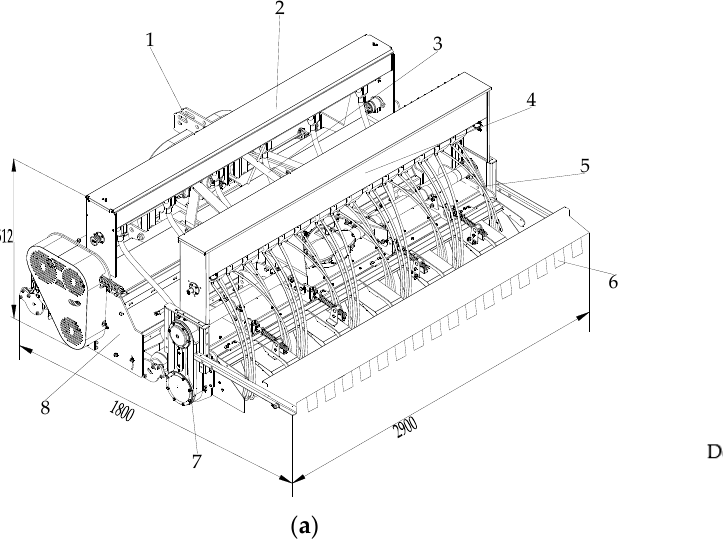
Figure 2. Overall structure of the wheat wide-seed-belt sowing and covering soil test bed: (1) hanging at the first three points; (2) fertilizer box; (3) hanging at the back three points; (4) seed box; (5) seed tube; (6) soil curtain; (7) transmission mechanism; (8) frame; (9) power input shaft; (10) seed guide tube. ( a ) Three-dimensional diagram; ( b ) side view.